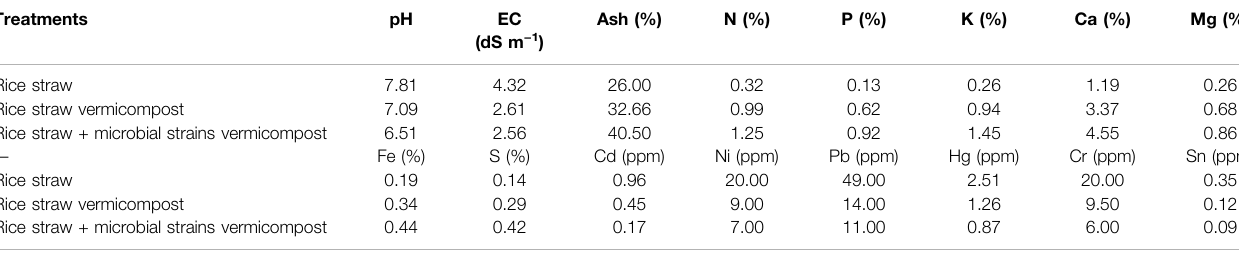
TABLE 1 | Analysis of raw material, vermicompost, and cellulolytic microbe-enriched vermicompost. Treatments